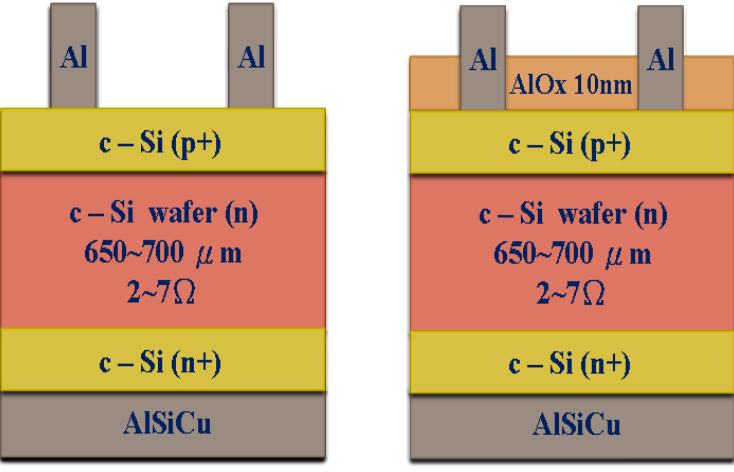
Figure 4. Comparison of without AlO